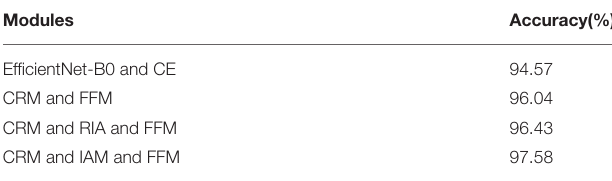
TABLE 6 | Contribution of proposed components and their combinations.